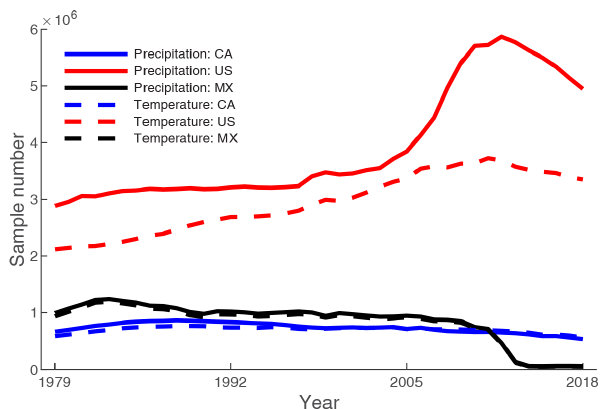
Figure 2. Sample numbers of stations for each year from 1979 to 2018. CA represents Canada, US represents United States, and MX represents Mexico. T max stations are highly consistent with T min stations, and thus T min is used to represent temperature. The num- bers of samples could be a better indicator than the numbers of sta- tions because many stations have notable missing values.